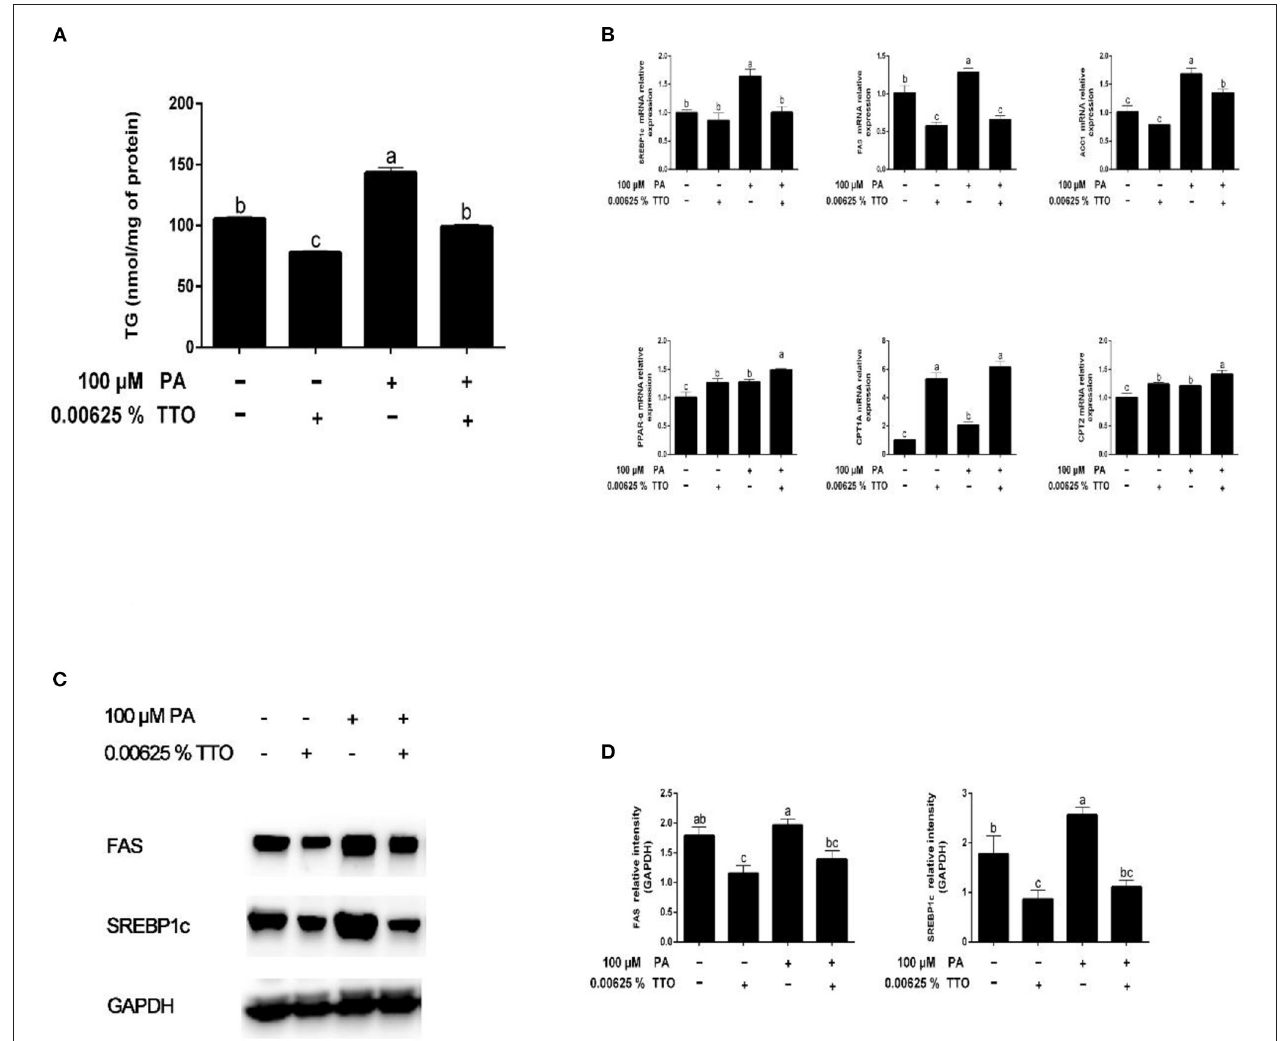
FIGURE 3 | Effect of TTO on genes and proteins related to fatty acid metabolism and TG content in PA-stimulated hepatocytes. (A) TG content. (B) Expression of genes related to fatty acid metabolism, normalized to GAPDH content. (C,D) Intensity of bands in immunoblots (C) and images of blots (D) . Protein expression was normalized to GAPDH content. All results are expressed as mean ± SEM. These data are representative of three independent experiments.